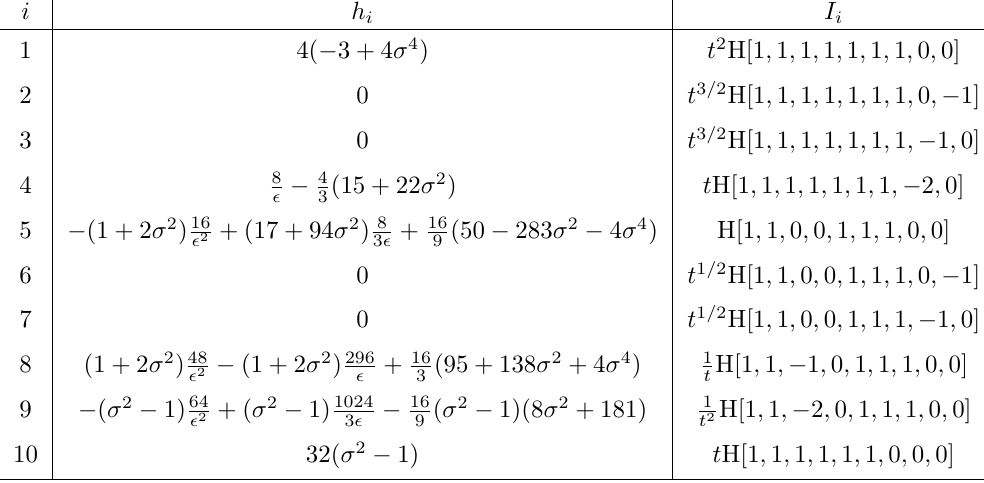
Table 2 . Coe(cid:14)cients and master integrals obtained from reducing graph 7 in (cid:12)gure 14. The integrals in the third column are the master integrals de(cid:12)ned in eqs. (8.2) and (8.3). The de(cid:12)nition of I 10 is provided by the third entry of the last line of this